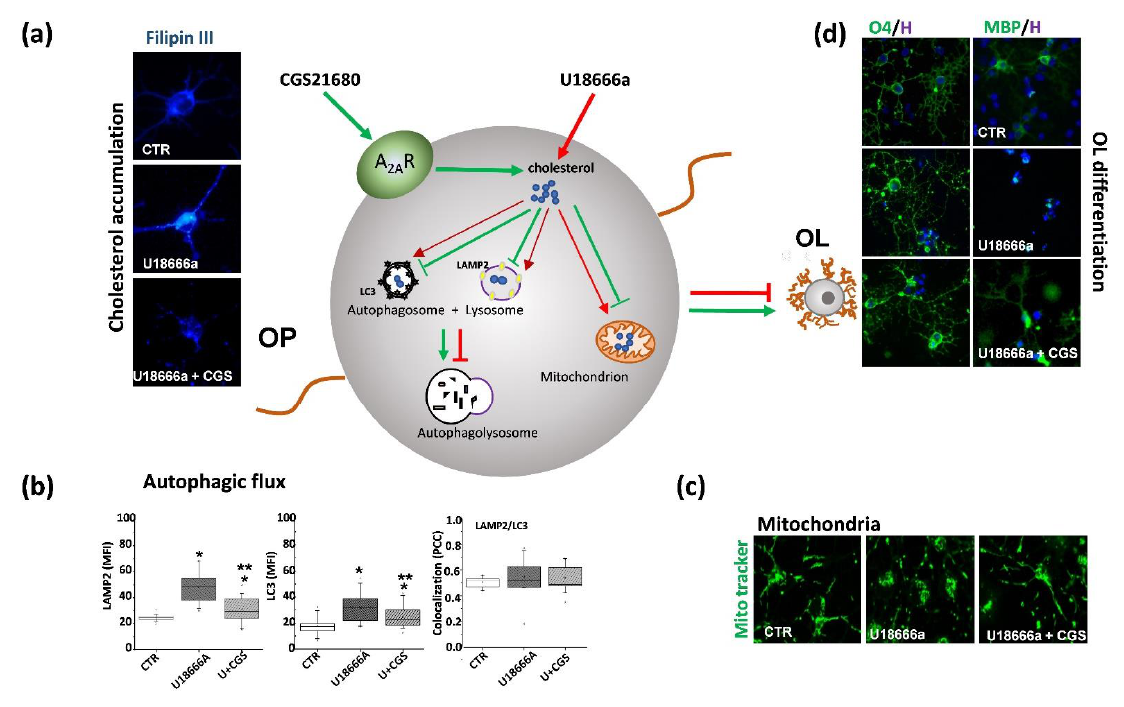
Figure 3. CGS21680 restores oligodendrocyte functions and differentiation in the NPC-like pharmacological culture model. The A 2A R agonist CGS21680 counteracts the effects induced by the cholesterol transport inhibitor U18666A, known to induce an NPC-like phenotype: ( a ) by reducing the accumulation of cholesterol, as shown by the cholesterol probe Filipin III; ( b ) by restoring the autophagic flux, as evidenced by normalization of LC3 and LAMP2 markers (* p < 0.05 vs CTR; *** p < 0.05 vs U18666A); ( c ) by normalizing mitochondrial morphology and membrane potential; ( d ) by counteracting the maturation arrest and favoring OLs differentiation toward cells responsible for myelin formation. Green and red lines illustrate CGS21680 and U18666A effects, respectively; arrows and truncated lines indicate positive and negative effects, respectively.